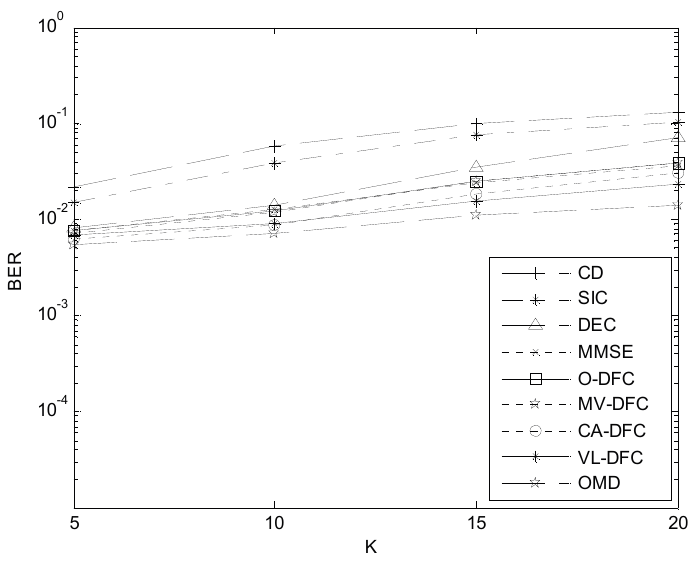
Figure 8. The BER versus K curves in AWGN channel when E b / N 0 = 5 dB.